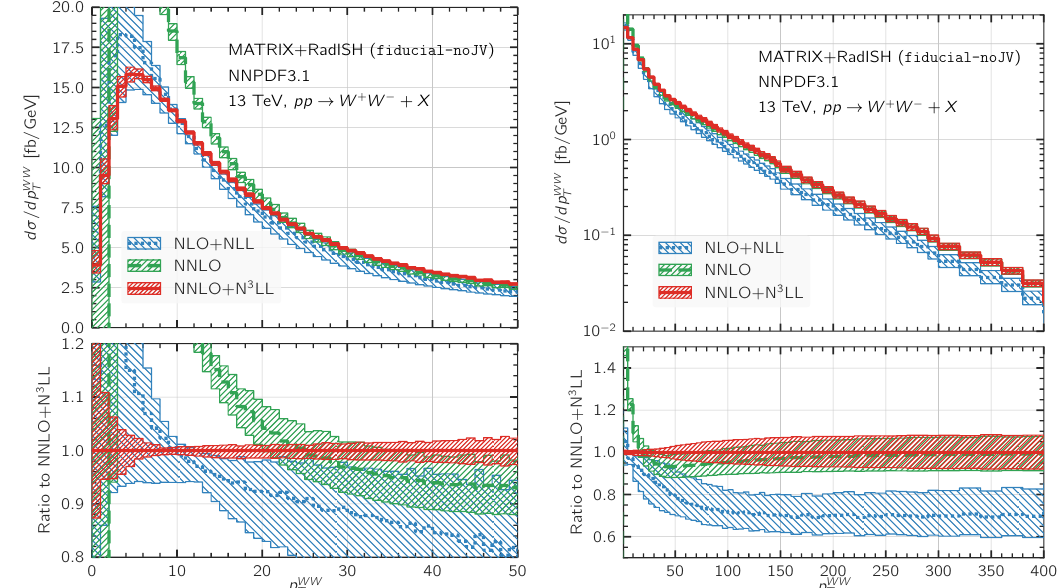
Figure 5 . Transverse-momentum spectrum of the W + W − pair in the fiducial-noJV phase space at NLO+NLL (blue, dotted), NNLO (green, dashed), and NNLO+N 3 LL (red, solid) accuracy. Left plot: spectrum up to 50 GeV. Right plot: spectrum up to 200 GeV. The lower frames show the ratios of the predictions to the central value of our best prediction at NNLO+N 3